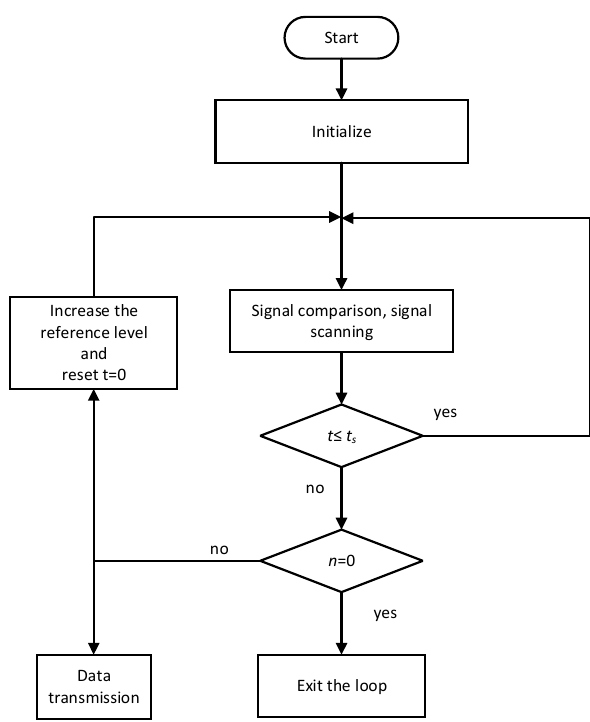
Figure 4. Flowchart of the data processing program.